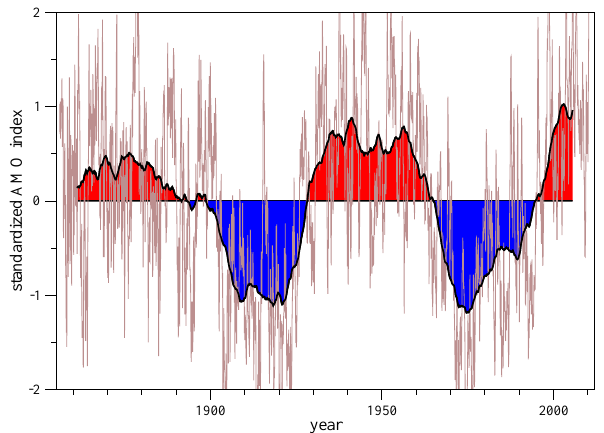
Fig. 1. Standardised monthly mean SST anomalies (thin line) and AMO index (ten years running mean, thick line and red/blue colours) calculated from the Kaplan SST data set which is updated monthly at http://www.cdc.noaa.gov/Timeseries/AMO/.